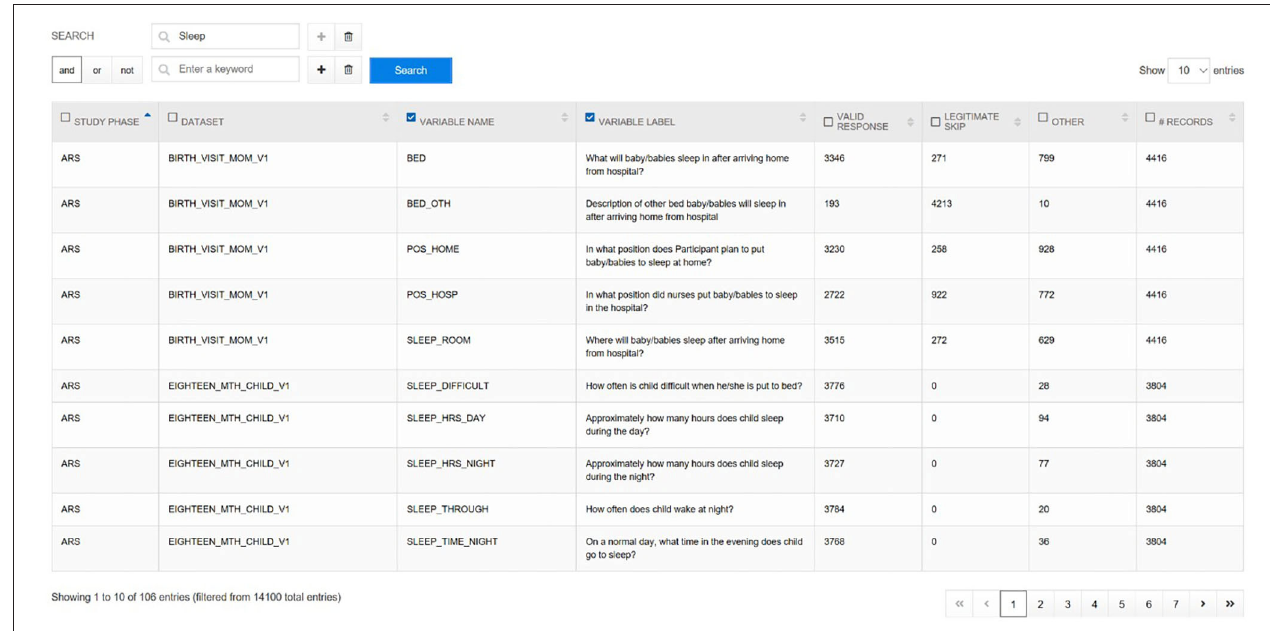
FIGURE 6 | NCS Archive Variable Locator.